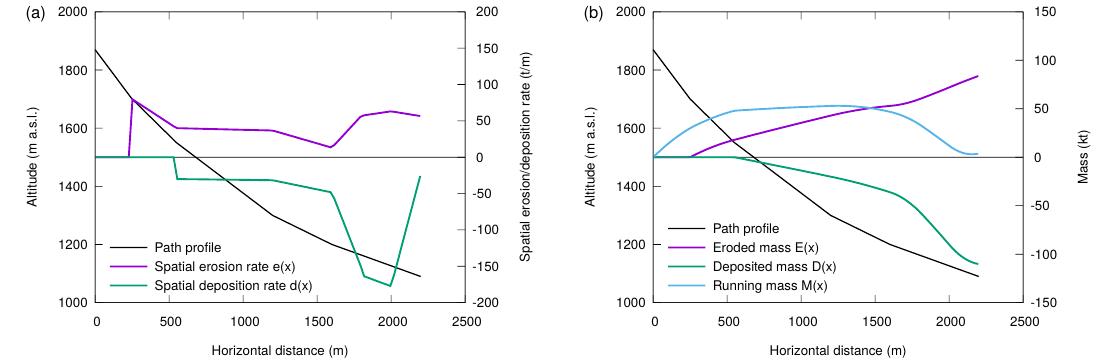
Figure 7. Qualitative evolution of erosion, deposition and mass balance. ( a ) Width-integrated erosion rate e ( x ) and deposition rate d ( x ) . ( b ) Evolution of running mass M ( x ) (mass passing the cross (cid:82) x e ( x (cid:48) ) d x (cid:48) , and the cumulated deposition, D ( x ) = section at x ), the cumulated erosion, E ( x ) = x sw (cid:82) x d ( x (cid:48) ) d x (cid:48) . x sw is the location of the stauchwall. Note that M ( x sw ) + E ( x ) + D ( x ) = M ( x ) for x sw x > x sw . For x < x sw , a linearly decreasing width of the release area is assumed in M ( x )